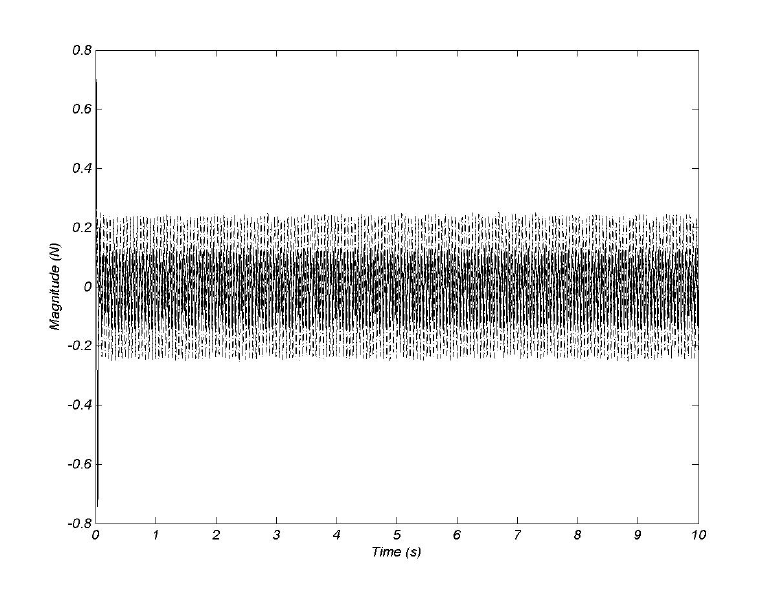
Fig. 29. Transmitted force variations of the system using the both PID and NN controllers subjected to periodic engine disturbance at idling frequency. PID controlled (–) and NN controlled (solid).